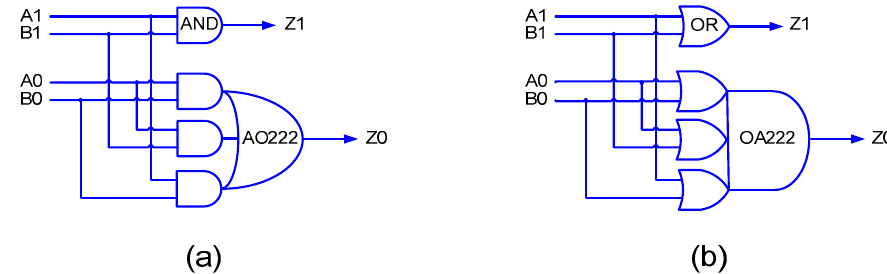
Figure 5. Proposed early output implementation of the 2-input AND function corresponding to: ( a ) RTZ handshaking, and ( b ) RTO handshaking.